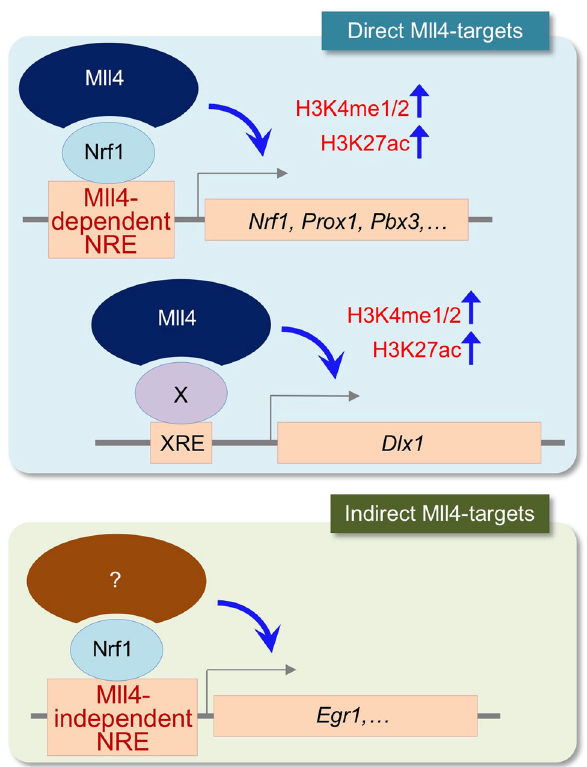
Fig. 8 Model for Mll4 action in developing GHRH-neurons. Mll4 partners mainly with Nrf1 epigenetically activating the common target genes of Mll4 and Nrf1 by enhancing the levels of H3K4me1/2 and H3K27ac. These common targets also include the Nrf1 gene itself, resulting in indirect activation of Mll4-independent target genes of Nrf1 by Mll4 (i.e., indirect target genes of Mll4). Mll4 also partners with unknown transcription factors, for instance to activate Dlx1